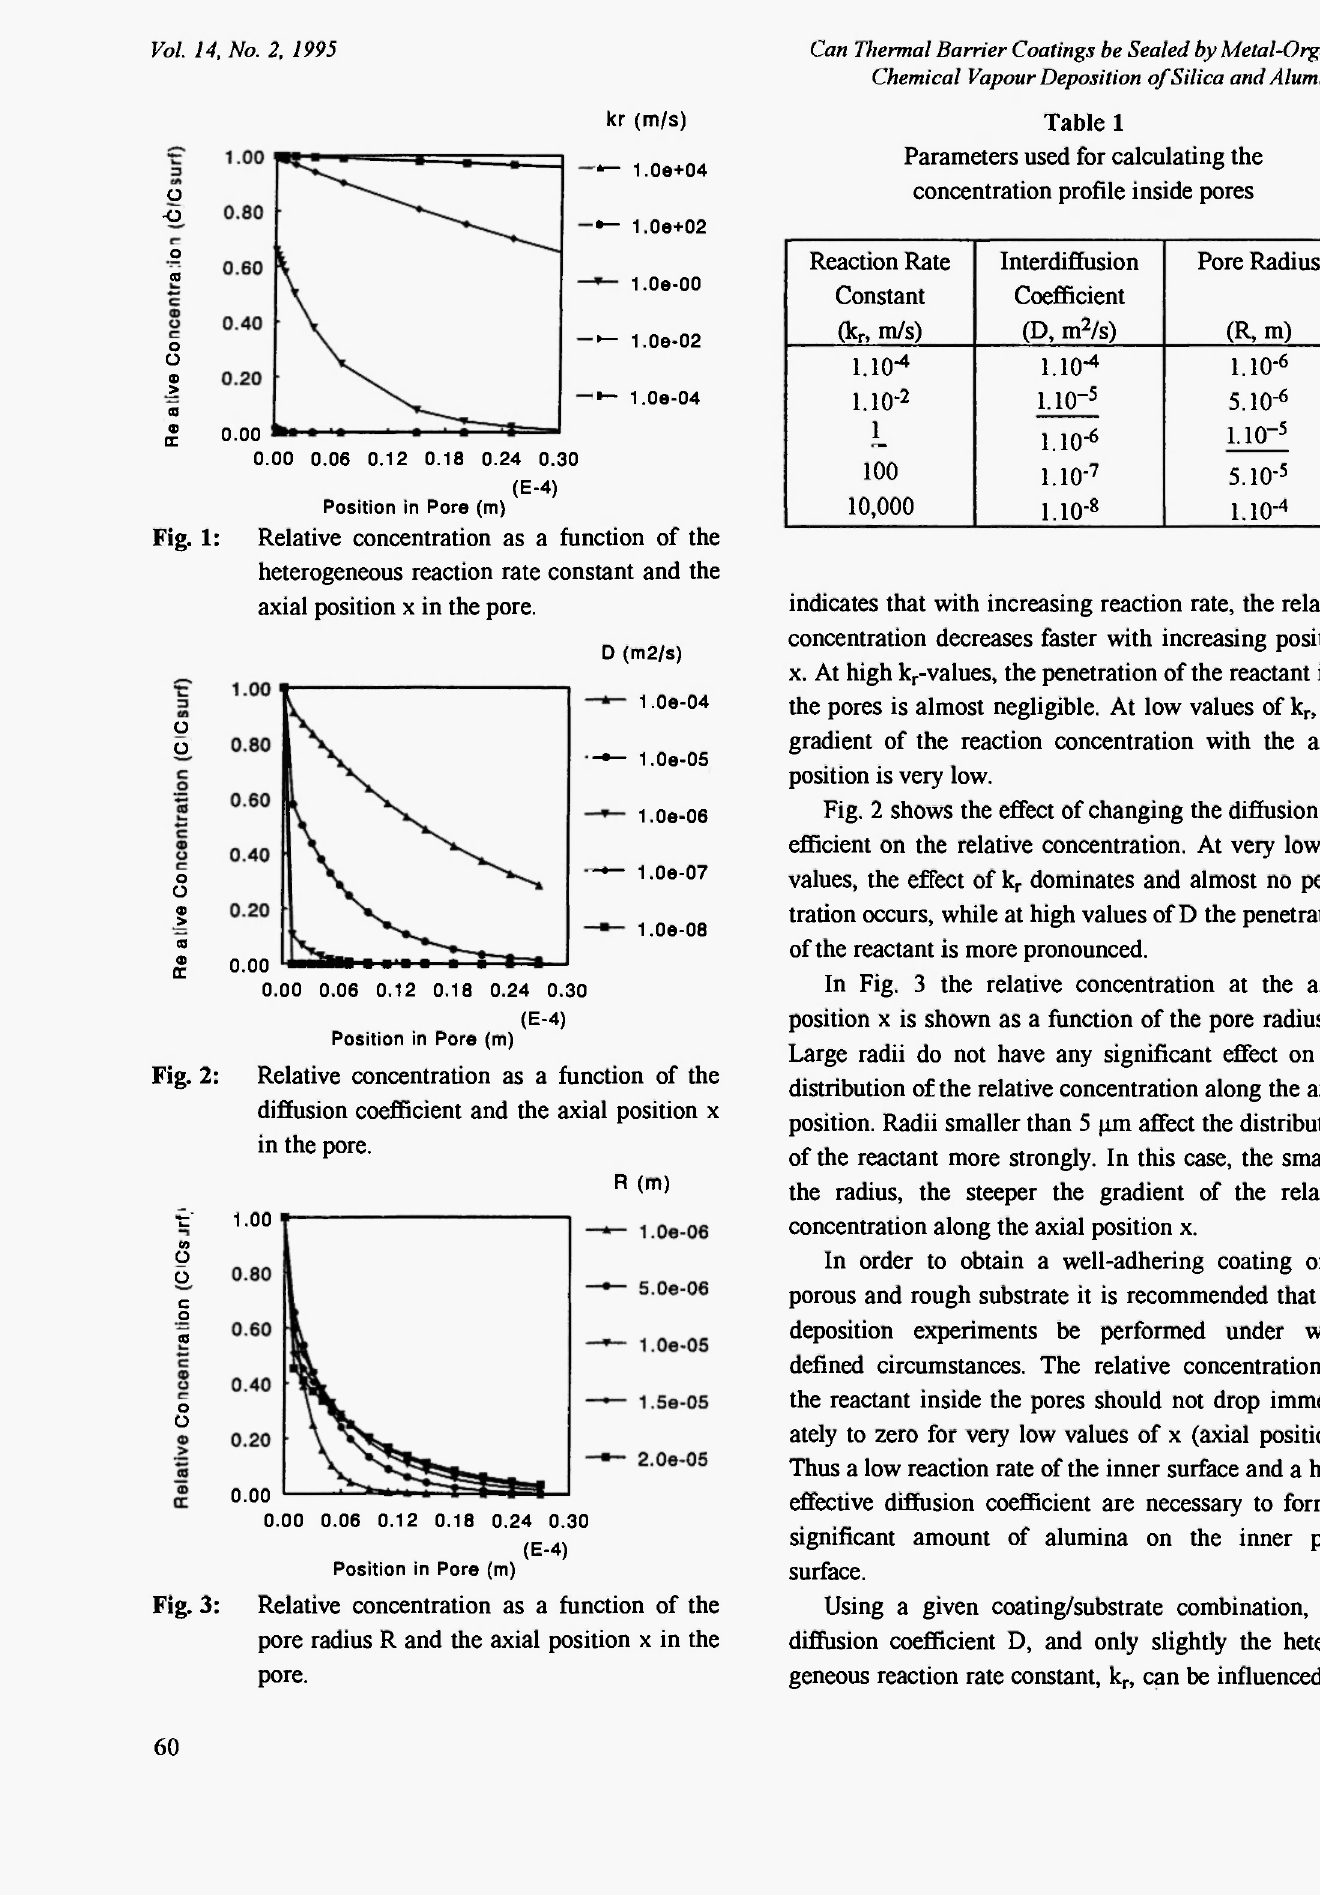
Parameters used for calculating the concentration profile inside